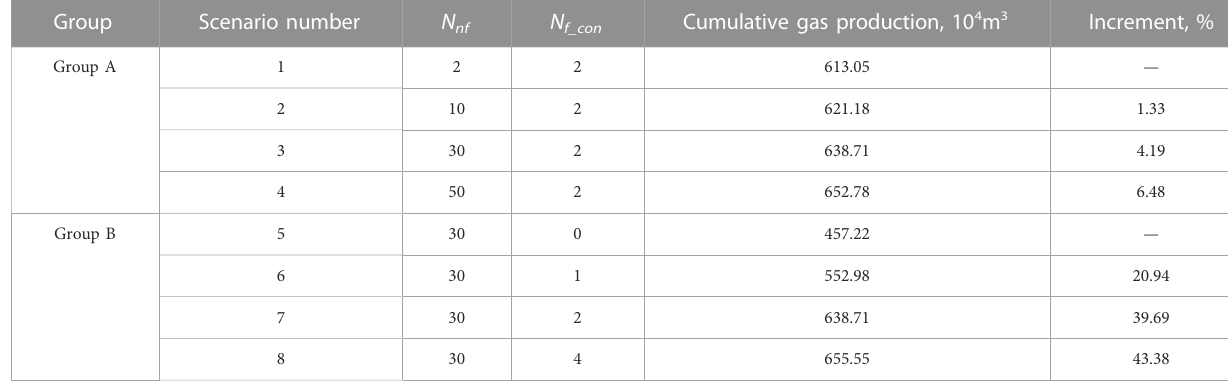
TABLE 2 Comparison of cumulative gas production of different scenarios with different values of N nf and N f_con .